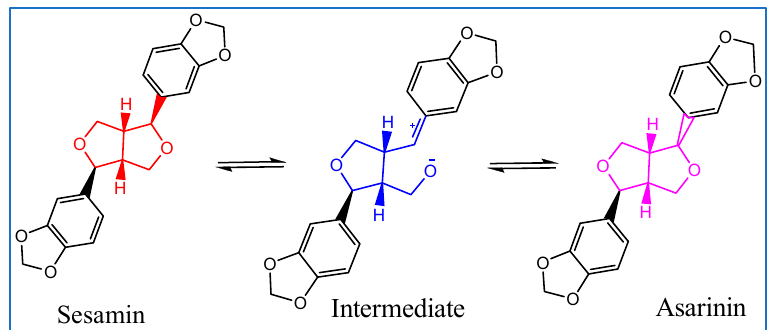
Figure 1. The mechanism of conversion of sesamin into asarinin.